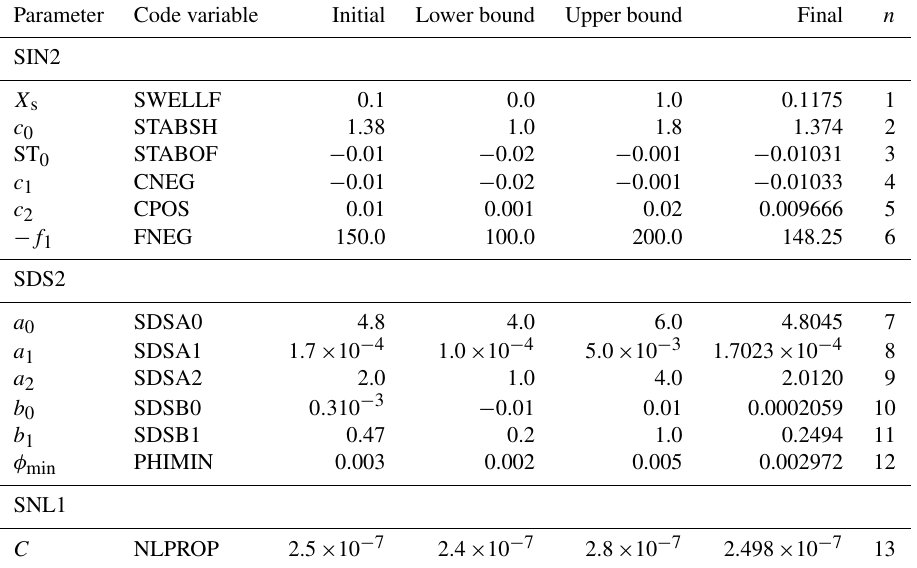
Table 2. Parameters used to calibrate the simulation using the source term package of Tolman and Chalikov (1996), for February through April 1997. The first two columns list the parameter as defined in the WW3 v4.18 user manual (Tolman, 2014) and as specified in WW3 namelist input. The namelist groupings correspond to parameterisations related to wind input (SIN2), dissipation (SDS2), nonlinear in- teractions (SNL1) and some “miscellaneous” parameters (MISC). Lower and upper bounds are specified for parameters adjusted during calibration, along with their final values, and the corresponding index n of the normalised parameter vector, as used to label plots in Fig. 3. Other parameters were fixed at the initial